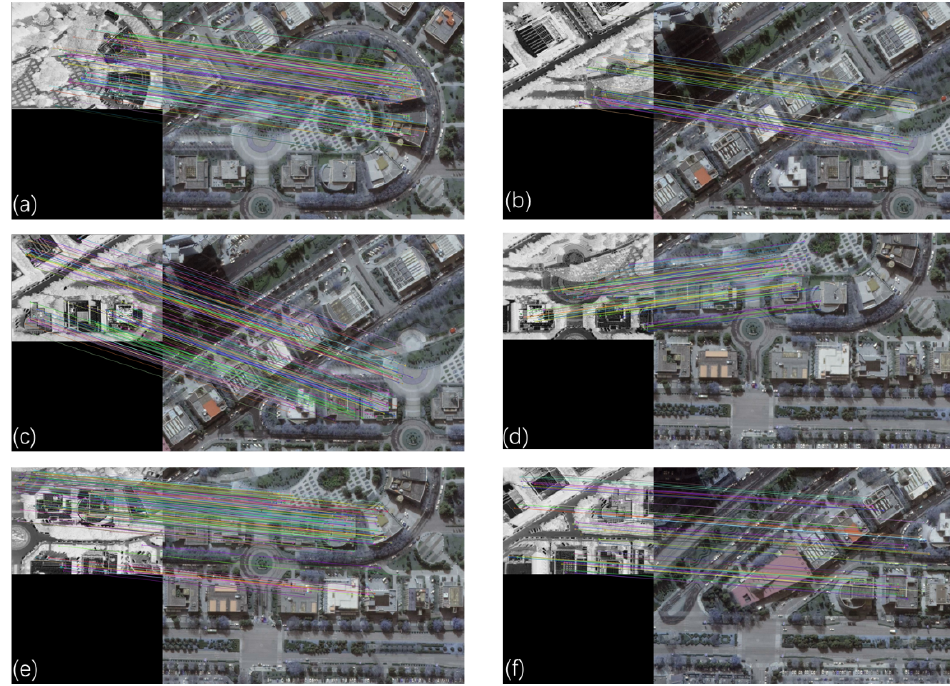
Figure 14. Six image matching ( a – f ) results of the samples in Figure 12 and the subimages of the reference satellite image in Figure